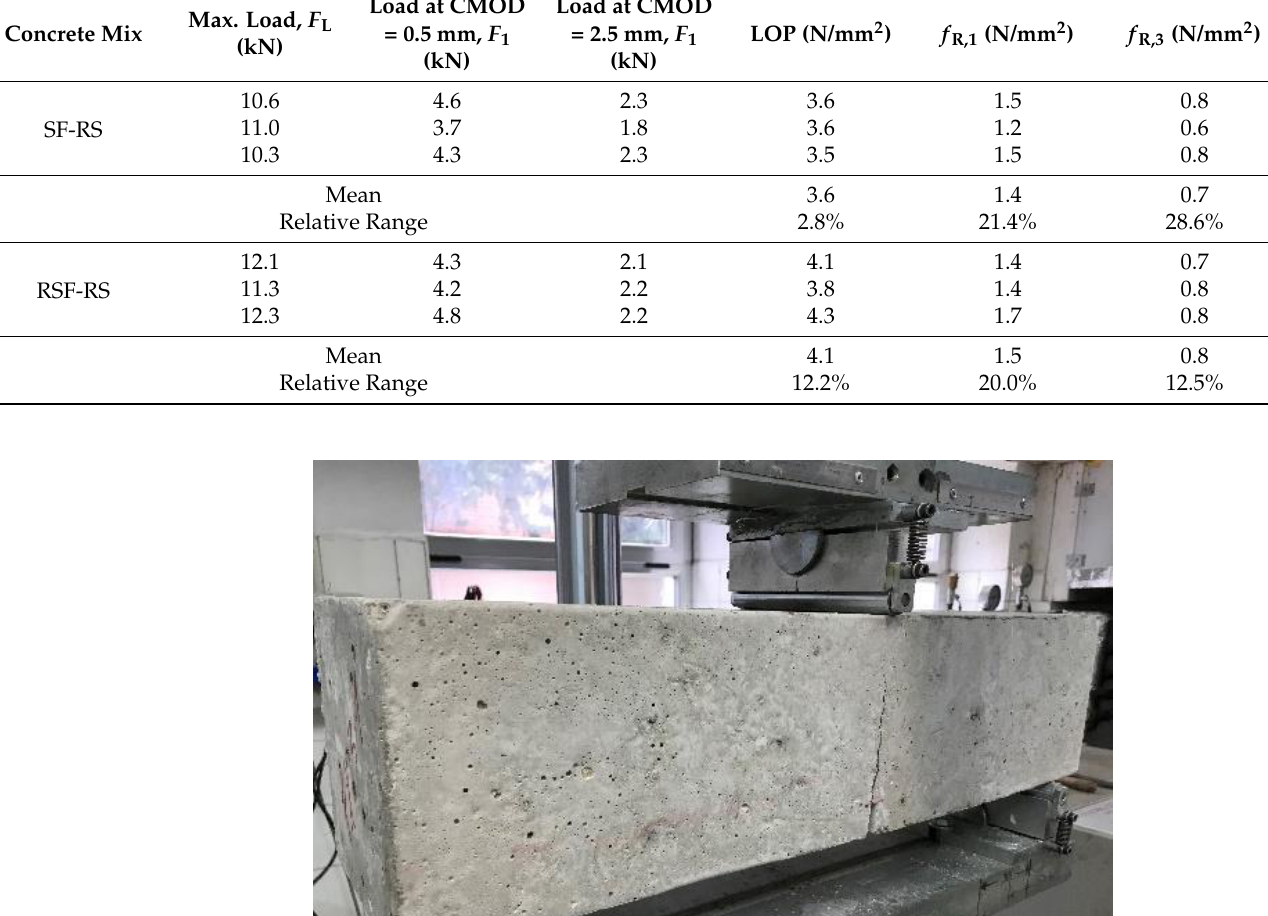
Figure 11. Load vs. CMOD curves according to EN 14651 [58] for determining flexural residual strength: SF-RS ( a ), RSF- RS ( b ), and average curves (mean of the three specimens per mix) for both mixes ( c ). Table 6. Flexural residual strength according to EN 14651 [58].